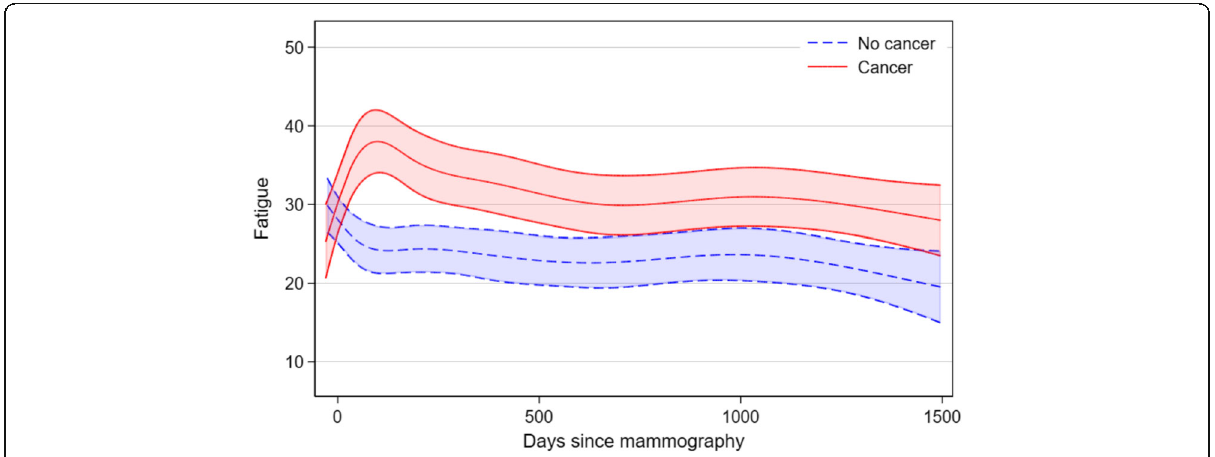
Fig. 2 Mean fatigue in women with and without breast